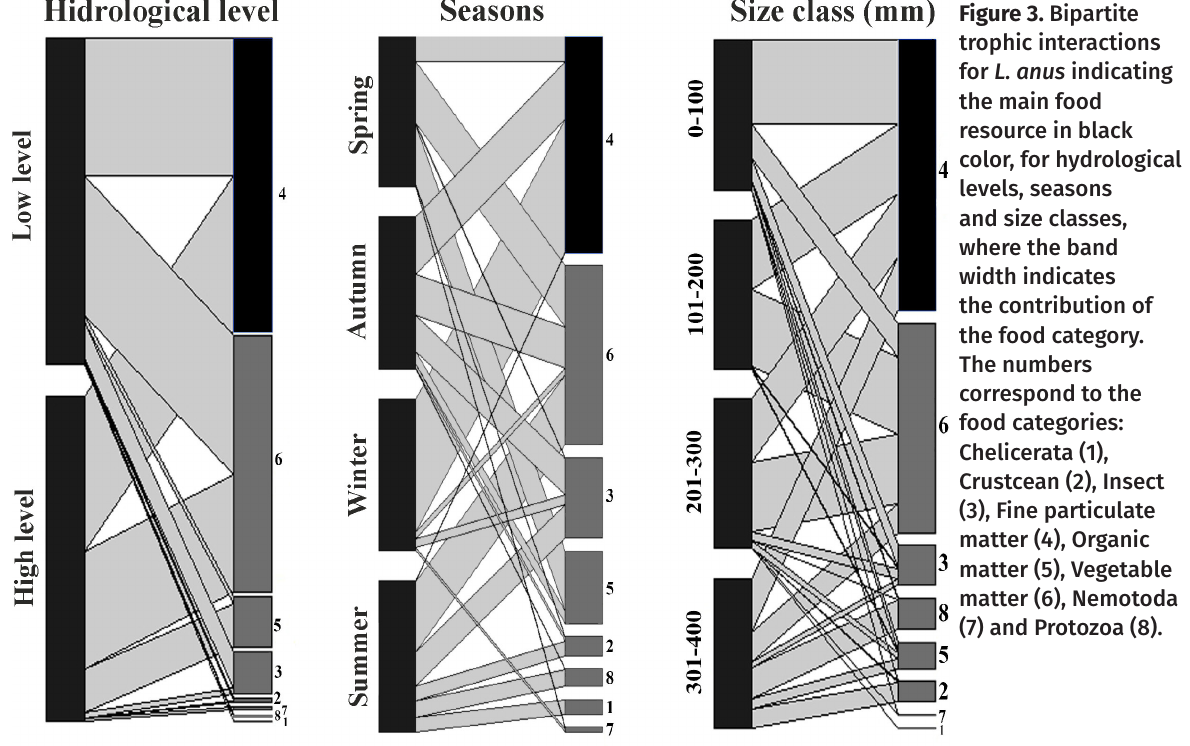
Figure 3. Bipartite trophic interactions for L. anus indicating the main food resource in black color, for hydrological levels, seasons and size classes, where the band width indicates the contribution of the food category. The